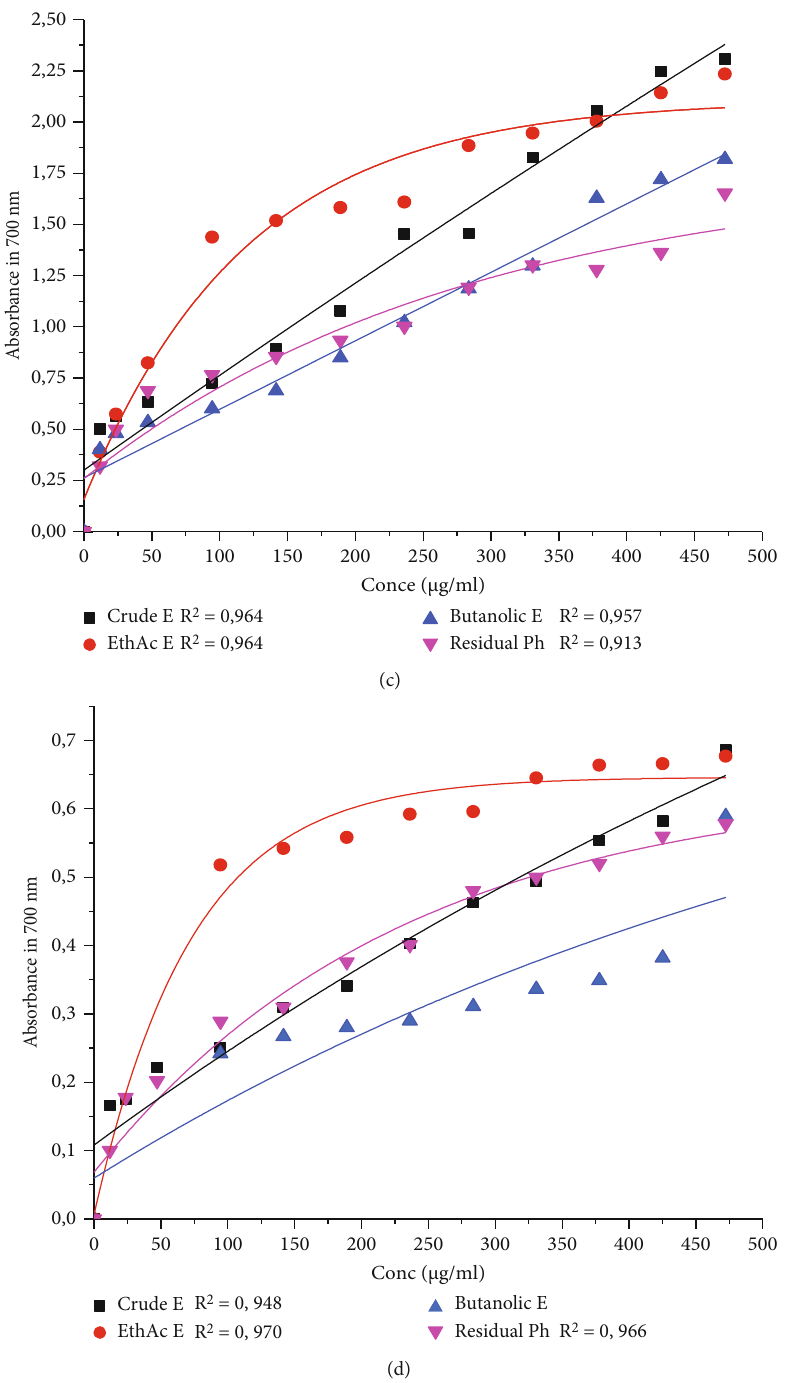
Figure 7: Iron reduction by Pistacia atlantica and reference standards: (a) standards, (b) leaves, (c) fruits, and (d)